Question: Provide a one-line summary of what is displayed.
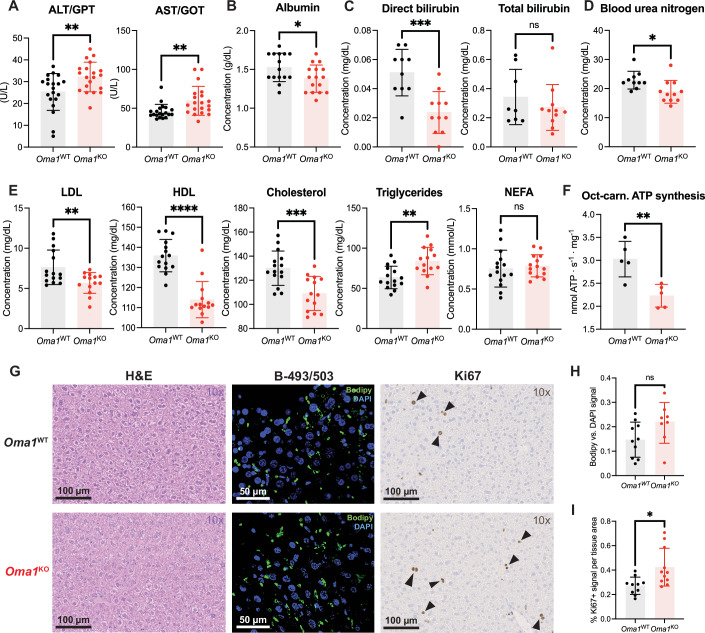
Answer: Early liver dysfunction in young Oma1 KO mice. ( A ) Plasma ALT-GPT ( P = 0.0074), AST-GOT ( P = 0.0021) from 10-week-old male Oma1 WT ( n = 20) and Oma1 KO ( n = 20) mice. “AST-GOT” values did not pass normality, while “ALT-GPT” passed normality. ( B ) Plasma albumin ( P = 0.0319) from 10-week-old male Oma1 WT ( n = 15) and Oma1 KO (n = 16) mice. “Albumin” values passed normality. ( C ) Plasma direct bilirubin ( P = 0.0006) and total bilirubin from 10-week-old male Oma1 WT ( n = 10) and Oma1 KO ( n = 11) mice. “Direct bilirubin” values passed normality, while “Total bilirubin” data did not pass normality. ( D ) Plasma BUN (0.0179) from 10-week-old male Oma1 WT ( n = 10) and Oma1 KO ( n = 11) mice. “BUN” values passed normality. ( E ) Plasma LDL ( P = 0.0068), HDL ( P < 0.0001), total cholesterol ( P = 0.0005), NEFAs and TAGs (0.0014) in 10-week-old male Oma1 WT ( n = 15), and Oma1 KO ( n = 14) animals fasted for 6 h. “HDL” values did not pass normality, while “LDL”, “Cholesterol”, “Triglycerides”, and “NEFA” passed normality. ( F ) ATP synthesis production using octanoyl carnitine ( P = 0.0063) in liver isolated mitochondria from 10-week-old fed male Oma1 WT ( n = 5) and Oma1 KO ( n = 5) mice. “Oct-carn. ATP synthesis” values passed normality. ( G ) Representative H&E, bodipy, and Ki67 staining analysis of 10-week-old fed Oma1 WT ( n = 10) and Oma1 KO ( n = 11) paraffin liver sections or whole-mount liver samples. Arrows indicate Ki67 staining-positive areas in liver tissue. ( H ) Bodipy fluorescence signal quantification ( P = 0.1238) in 10 weeks-old fed male Oma1 WT ( n = 10) and Oma1 KO ( n = 8) whole-mount liver samples. “Bodipy signal” values passed normality. ( I ) Ki67 signal quantification ( P = 0.0127) in 10-week-old fed male Oma1 WT ( n = 10) and Oma1 KO ( n = 11) paraffin liver sections. “%Ki67 signal” values did not pass normality. P value from unpaired two-tailed Student’s t test (when data passed normality) or Mann–Whitney test (when data did not pass